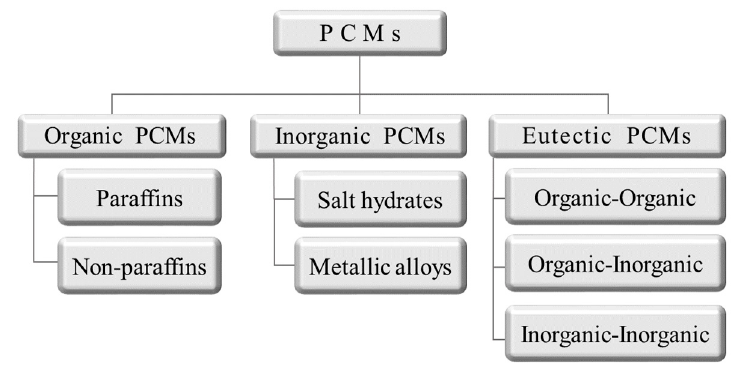
Figure 3. Scheme of phase-change material (PCM) classification [72].